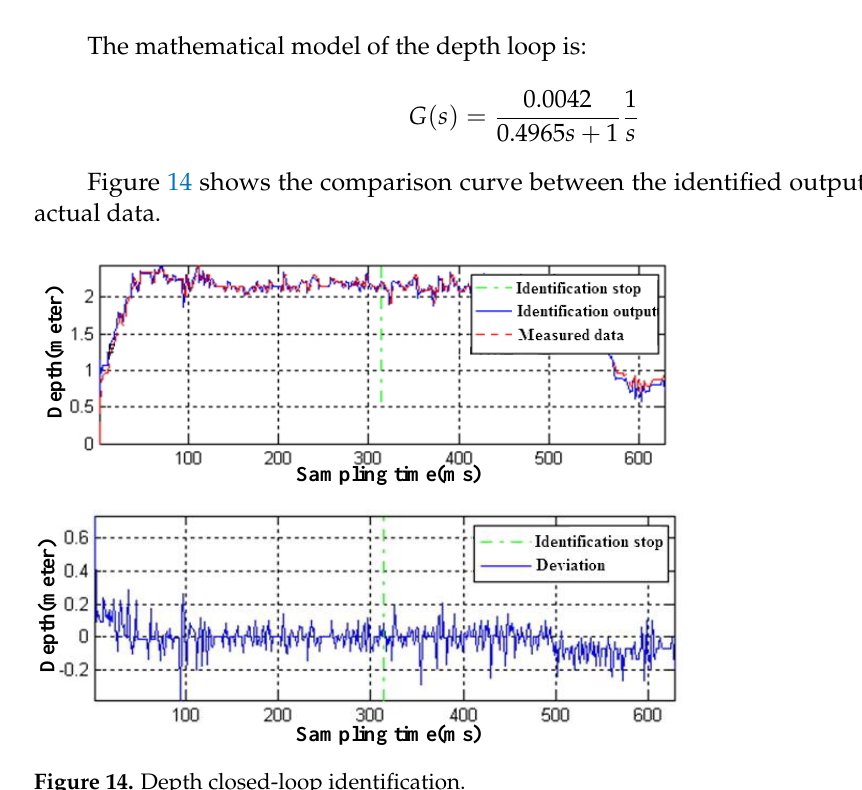
Figure 14. Depth closed-loop identification.